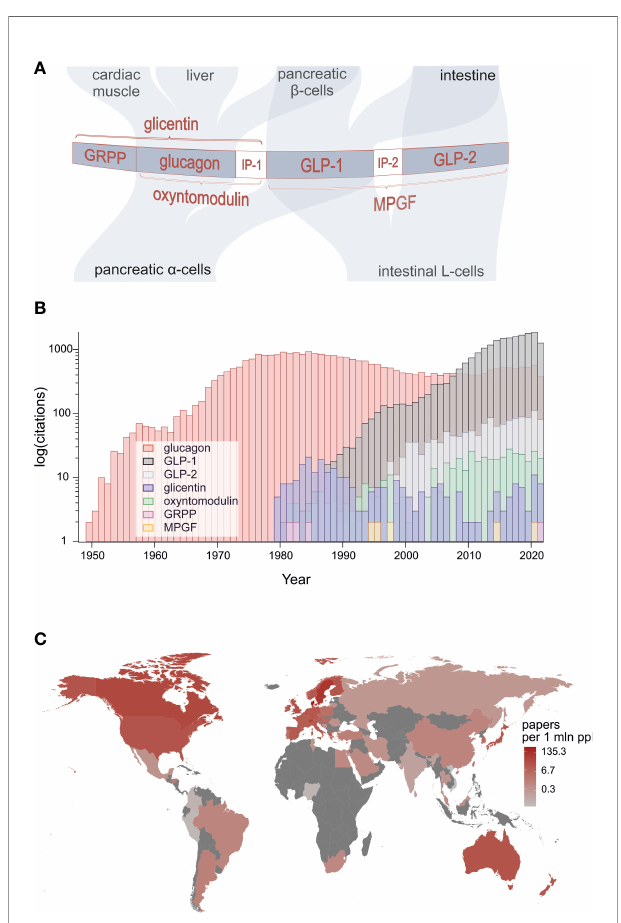
FIGURE 1 | (A) Structure of proglucagon, post-translational processing and the major targets of constituent bioactive peptides: glucagon, GLP-1, GLP-2, oxyntomodulin, glicentin and glicentin-related pancreatic polypeptide. (B) Numbers of peer-reviewed publications on proglucagon- derived peptides showing particularly strong surge of research on GLP-1. (C) Publication count by geographical location divided by population of each country (source: